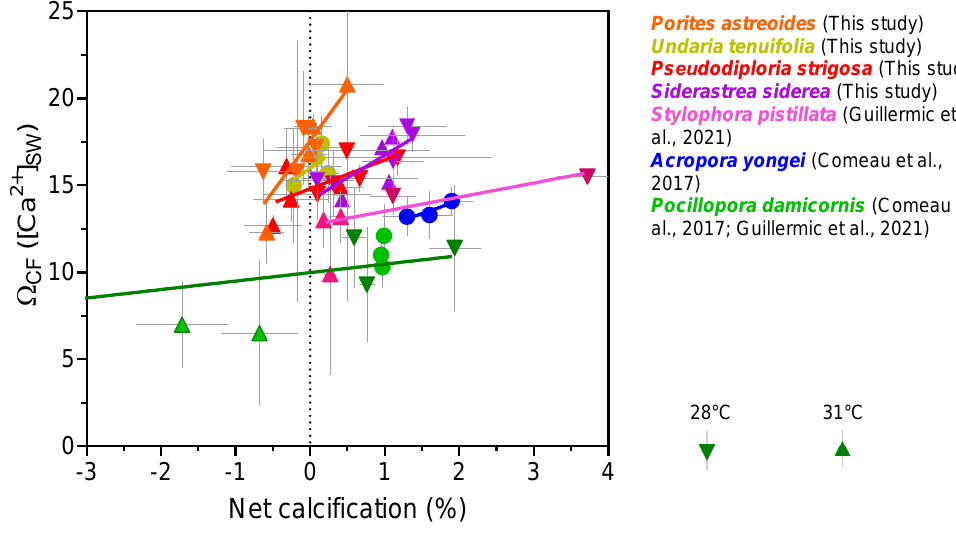
Figure 9. Relationships between boron isotope derived Ω CF and net calcification rates. Ω CF is calculated assuming that [Ca 2+ ] of seawater is equivalent to [Ca 2+ ] of the calcifying fluid. Published data used in this figure is given in Table S12 with citations for data